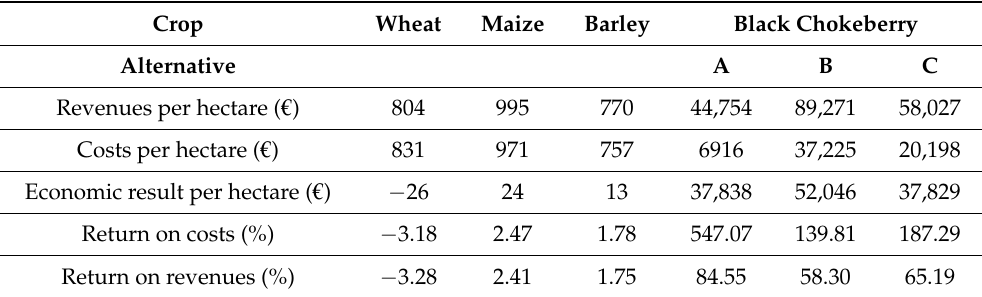
Table 3. Comparison of economic indicators among black chokeberry and selected conventional crops (intensive cultivation methods vs. maize production area). Crop Wheat Maize Barley Black Chokeberry Alternative A B C Revenues per hectare ( € ) 804 995 770 44,754 89,271 58,027 Costs per hectare ( € ) 831 971 757 6916 37,225 20,198 Economic result per hectare ( € ) − 26 Return on costs (%) − 3.18 Return on revenues